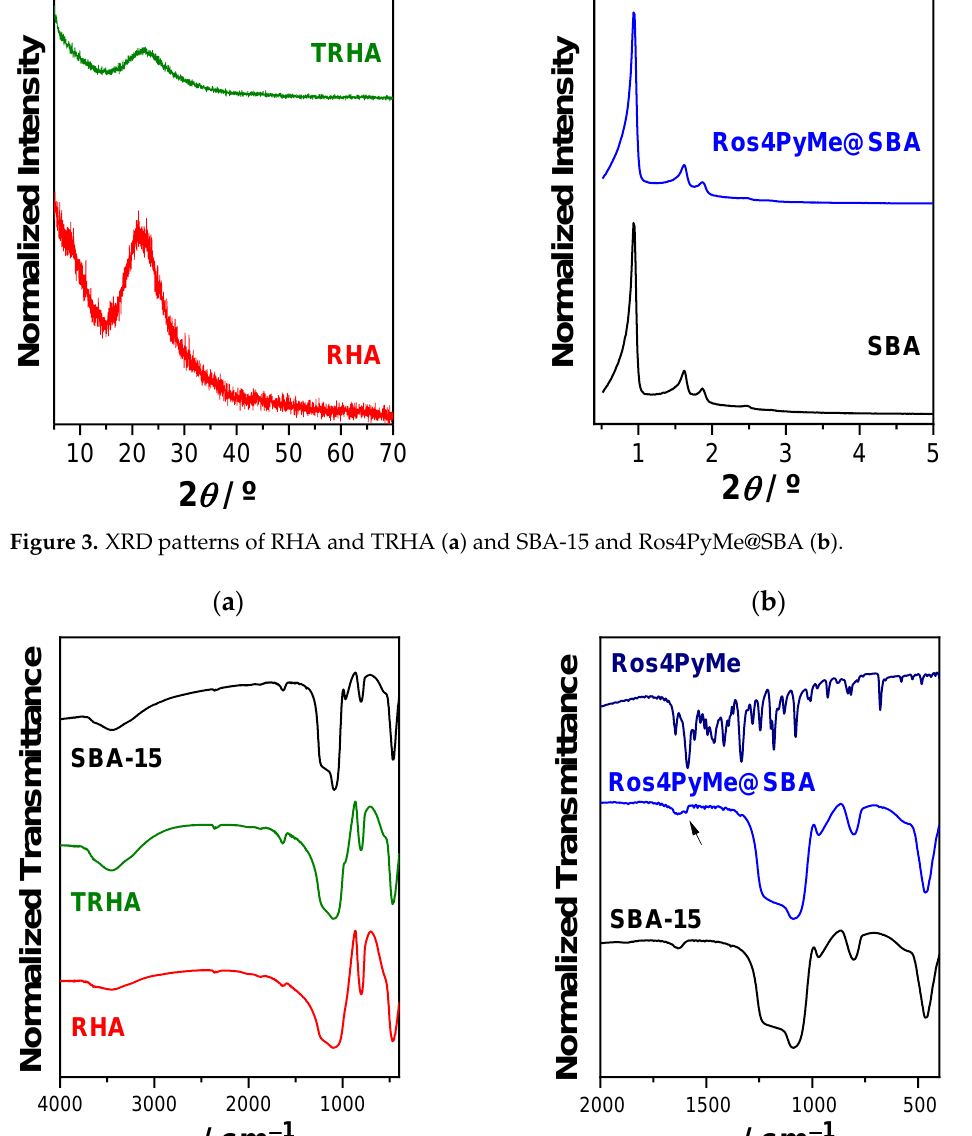
Figure 5. SEM images of RHA ( a ), TRHA ( b ), SBA-15 ( c ), and Ros4PyMe@SBA ( d ). 3.4. Amines Sensing According to several studies [26 – 28], mesoporous silica materials are suitable adsor- bents for amines and allow their detection; however, the applied sensing techniques are limited by the previous mentioned reasons [26]. Four amines were selected for the sensing studies: n -butylamine, aniline, and two biogenic amines, putrescine and cadaverine